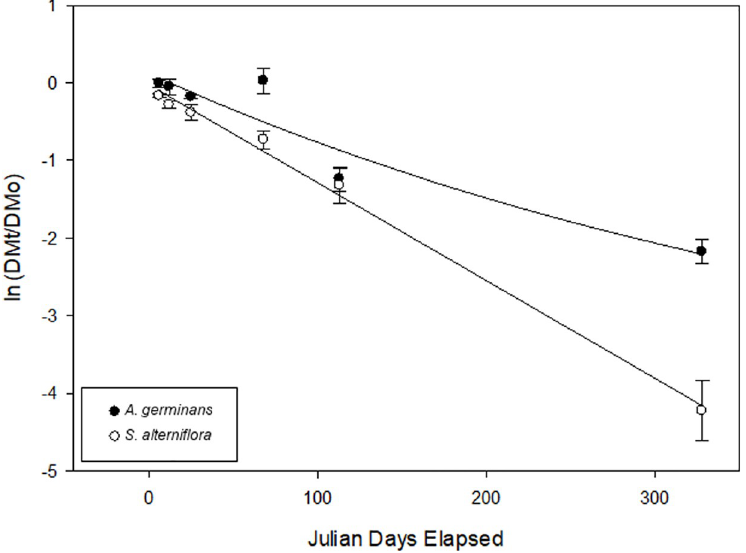
Fig 5. Decomposition of freshly senesced A . germinans and S . alterniflora leaf detritus. Y values, ln(DMt/DMo), are the natural logarithms of the proportion of detrital mass remaining at time, t. Duplicate bags of each plant type were collected 6, 12, 25, 68, 113, and 328 days after deployment. Upon retrieval, the samples were rinsed off with fresh water, and the contents within the bag carefully removed and sieved through a 0.5mm mesh. Samples were oven-dried (60˚C to constant mass) and converted to an air-dried weight using regressions obtained with additional samples. Least square regression for single exponential models (p < 0.05, A . germinans : r 2 = 0.90; S . alterniflora r 2 = 0.95). A . germinans leaf detritus decomposed slower than S . alterniflora leaf detritus (p < 0.05, Table 1).